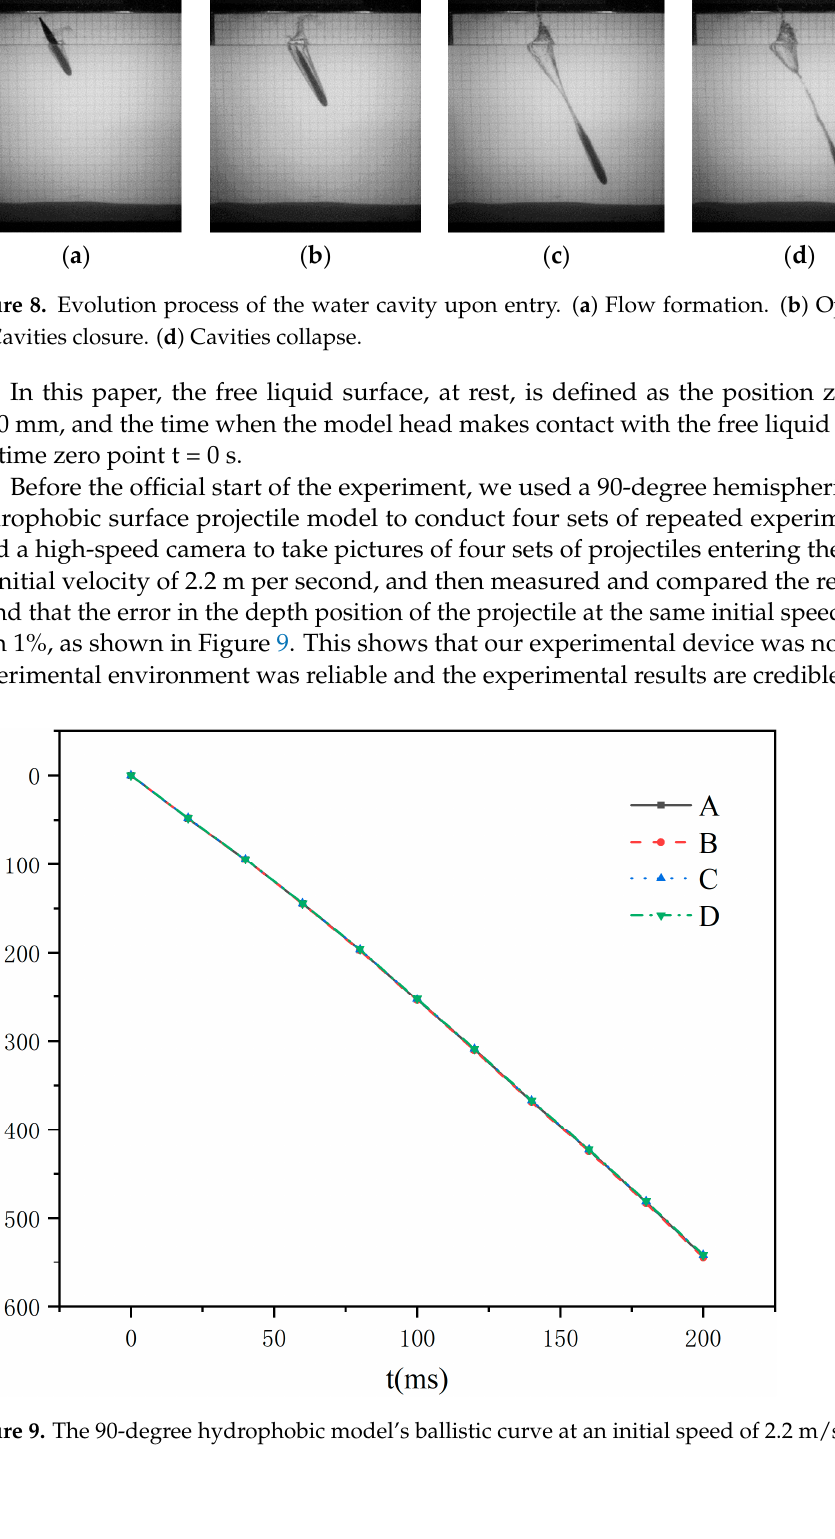
Figure 9. The 90-degree hydrophobic model’s ballistic curve at an initial speed of 2.2 m/s.